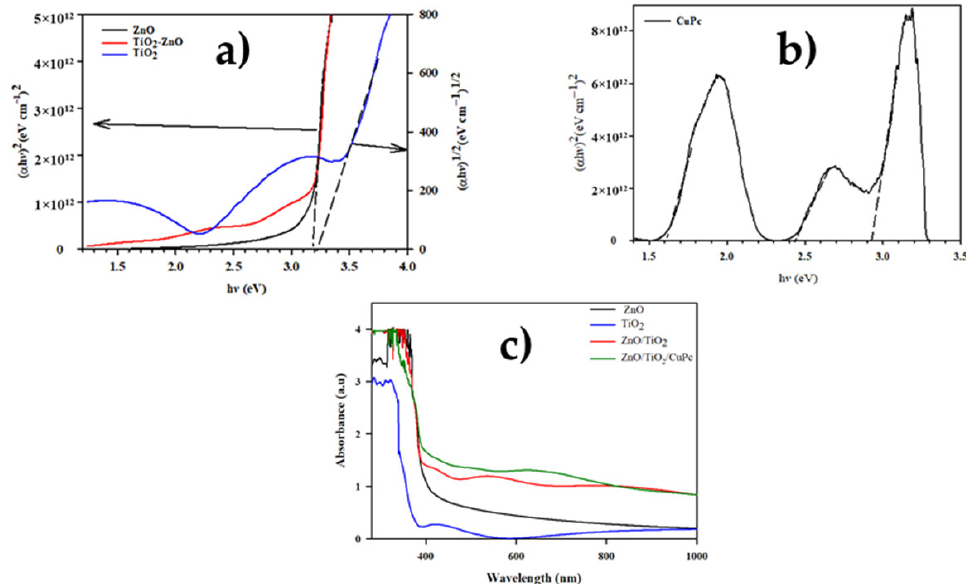
Figure 5. Tauc’s plots for energy band gaps (E g ) of ( a ) TiO 2 , ZnO, and TiO 2 /ZnO structures, ( b ) CuPc grown on quartz substrates, and ( c ) their respective UV-Vis absorption spectra measure- ments.